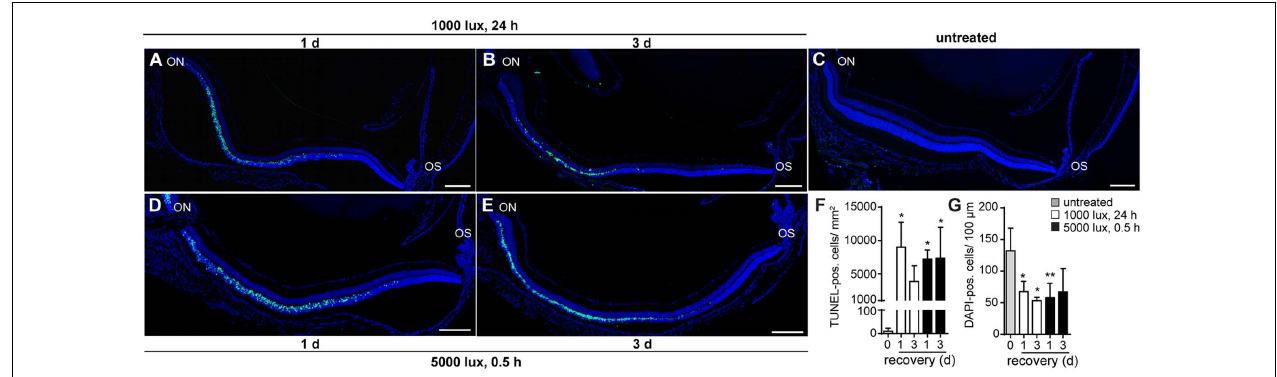
FIGURE 1 | Cell death occurs in the ONL 1 day post-light treatment. Detection of cell death in retinae of mice either treated with (A,B) 1000 lux (24 h) or (D,E) 5000 lux (0.5 h) was performed by TUNEL- (green) and DAPI-staining (dark blue) of cell nuclei. (C) Untreated, Balb/c mice did not show TUNEL-positive cells in the retina. Albino mice treated with light showed apoptotic TUNEL positive cells (green) in the ONL (A,D) 1 day and (B,E) 3 days after light exposure. There was a significant increase in numbers of (F) TUNEL positive cells and a significant decrease in numbers of (G) DAPI positive cells following light exposure, however, no significant differences in the numbers of (F) TUNEL- and (G) DAPI-positive cells regarding the light treatment regimen was observed. Scale bars, 200 µ m. ∗ 0.01 < P < 0.05, ∗∗ 0.001 < P < 0.01 (ordinary one-way ANOVA, Dunnett’s multiple comparisons test, with a single pooled variance) ON, optic nerve; OS, ora